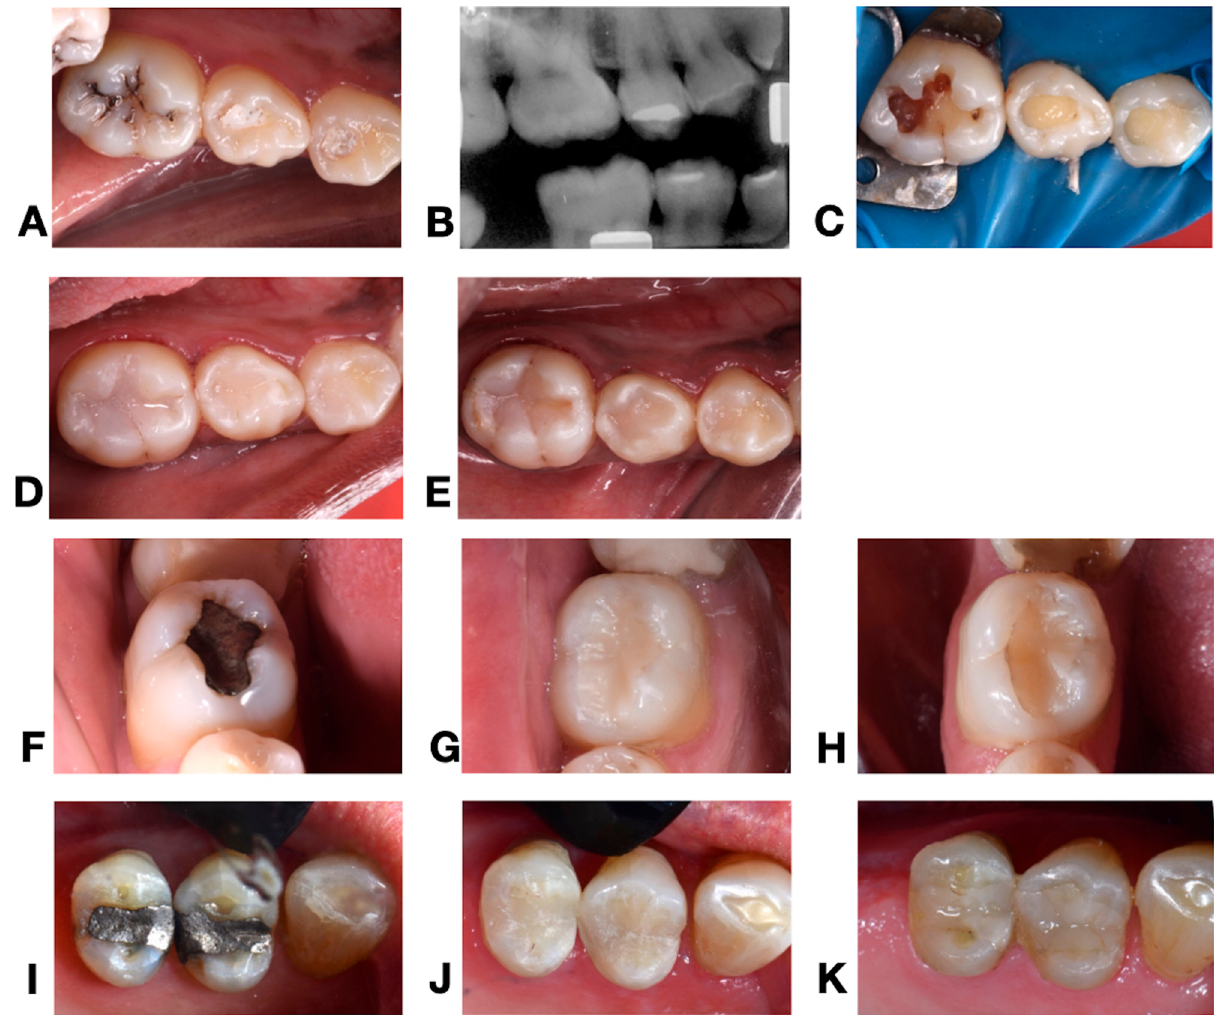
Figure 3- Representative photographs of clinical procedure and follow-up evaluation. (A) Baseline clinical photography of teeth 44, 45, and 46, (B) Baseline radiography, (C) Restorative procedure, (D) Immediately after the restorative procedure, (E) clinical evaluation after 24-month follow-up, restorations rated as “clinically very good” in all categories of the FDI criteria. (F) Tooth 46 with an amalgam restoration to be replaced, (G) tooth 46 immediately after the restorative procedure, (H) Clinical evaluation after 24-month follow-up,